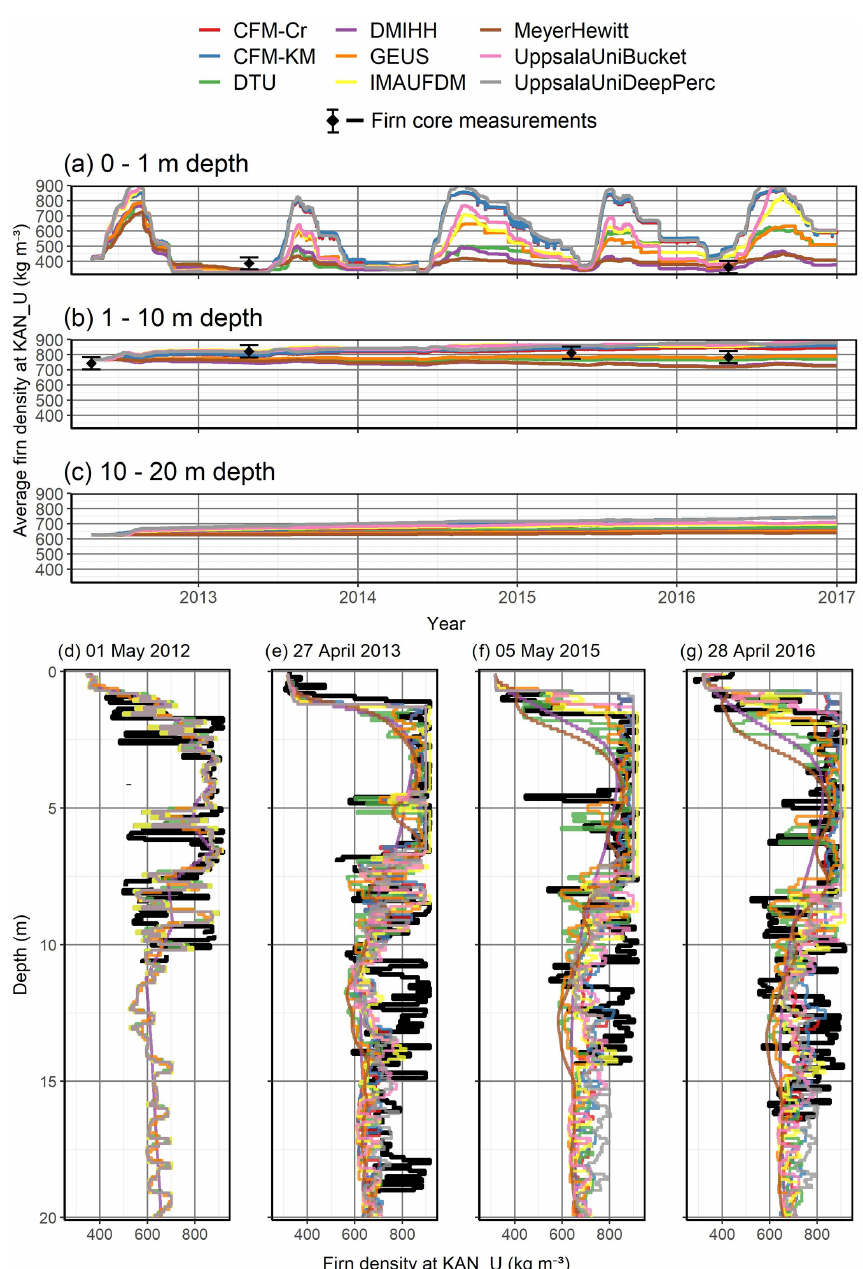
Figure 9. Modeled (colored lines) and observed (black diamonds with 40kgm − 3 uncertainty bars) average firn density for the top 1m (a) , the 1–10m depth range (b) and the 10–20m depth range (c) at KAN_U. Observed and simulated density profiles at KAN_U (d–g) .